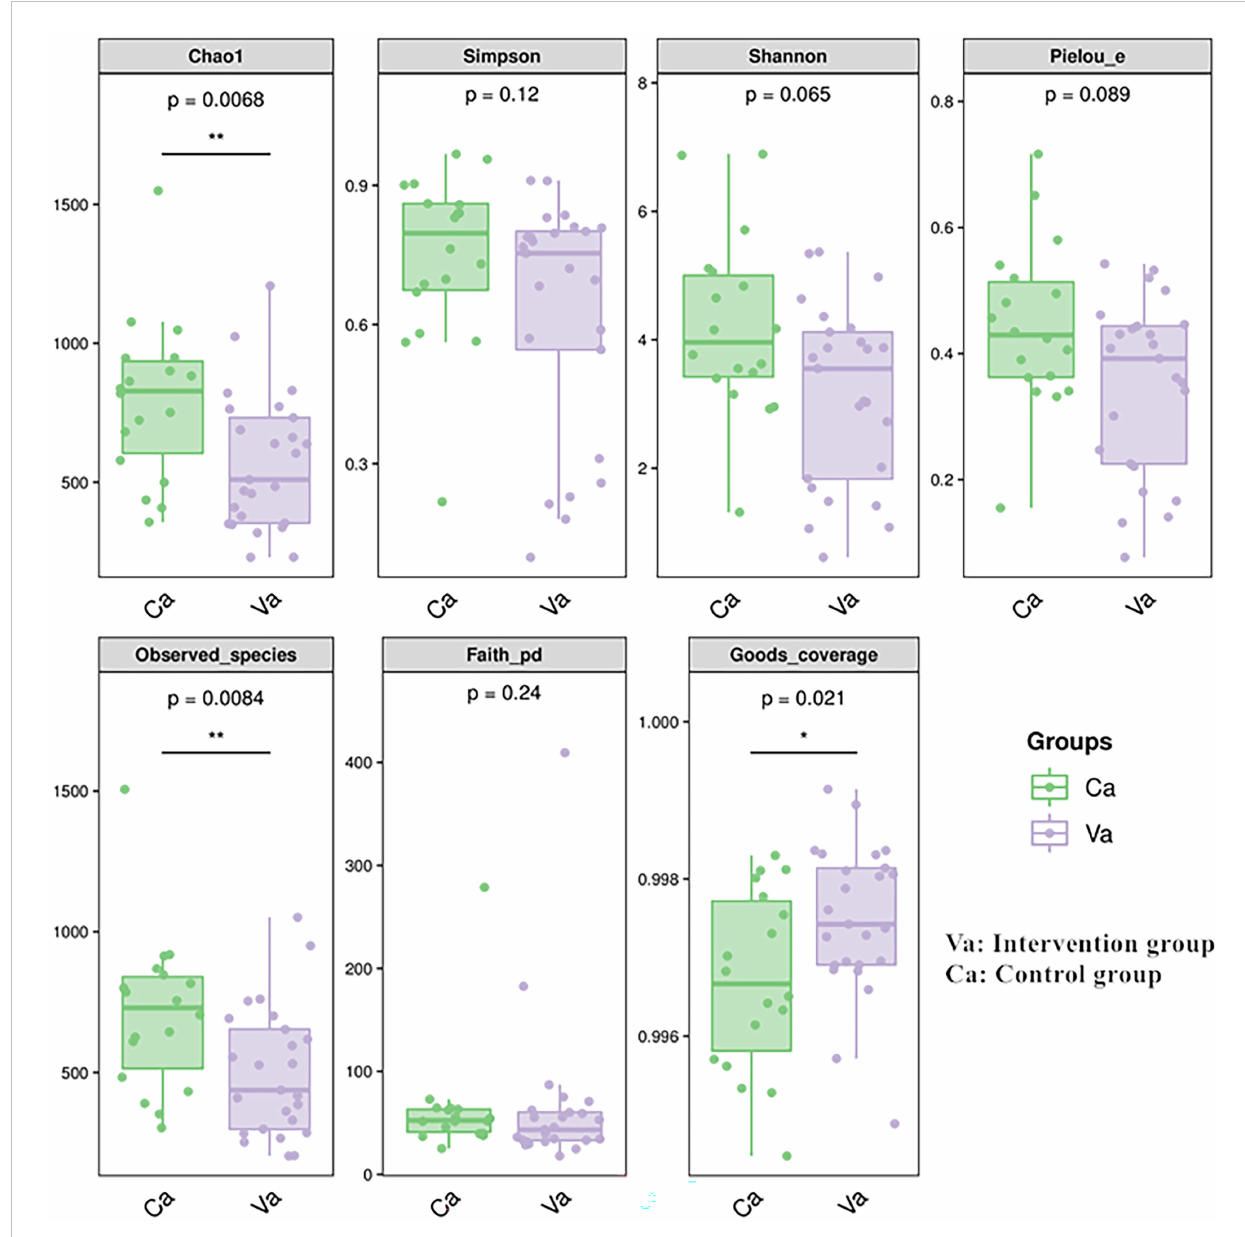
FIGURE 3 The Chao1 and observed species indices of abundance were signi fi cantly lower in the heart failure group than in the control group. The meaning of each symbol in the boxplot was as follows. The upper and lower end line of the box were the upper and lower Interquartile range. Median line of the box was the median. The upper and lower margins were the maximum and minimum internal circumference (1.5 times of interquartile range). Numbers under the diversity index label are